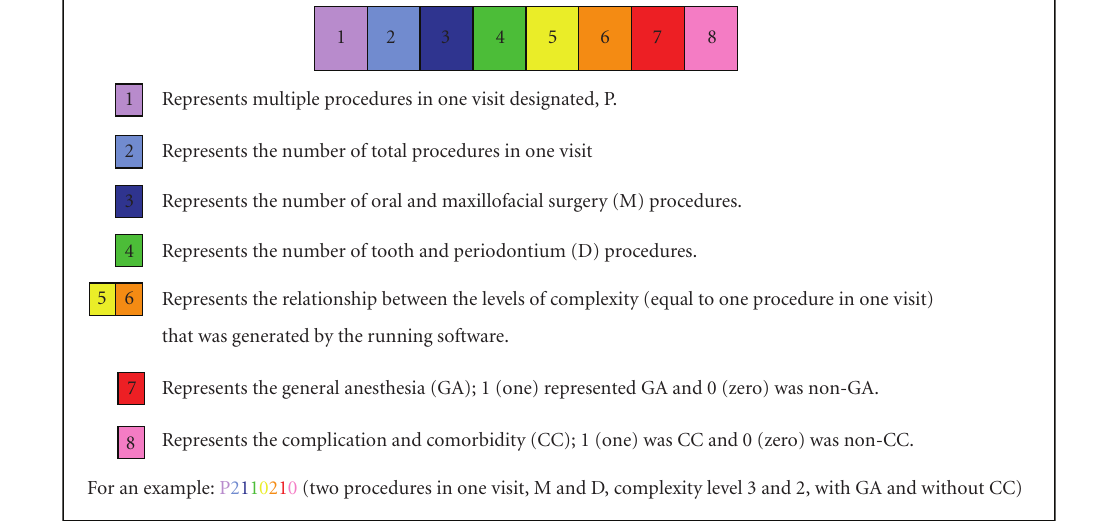
Figure 4: Diagram presents the casemix classification model of OHCS (multiple procedures in one visit) as represented in eight-digit